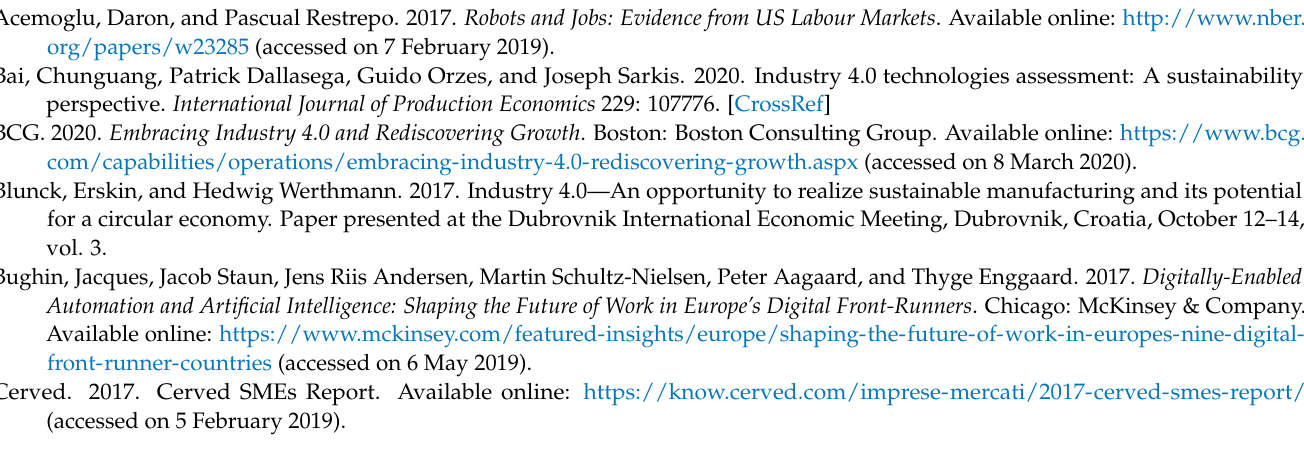
Figure A4. Components of a supervised learning algorithm. Source: Šnajder and Dalbelo Bašić (2014) (adjusted from the authors).